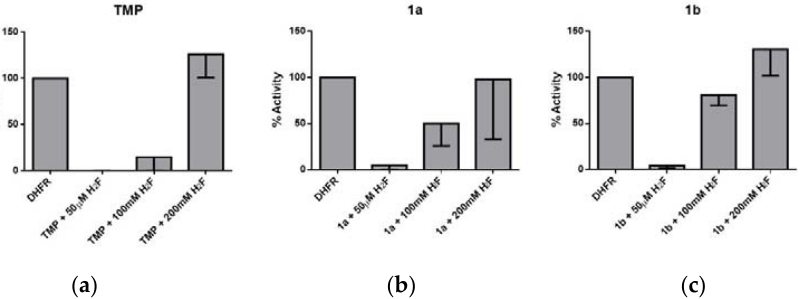
Figure 5. Percentage of activity of E. coli DHFR after a 30 ‐ min incubation. Each histogram represents the activity of DHFR in the presence of different concentrations of H 2 F and 5 μ M of the inhibitors ( a ) TMP, ( b ) 1a and ( c ) 1b . The data are expressed as a percentage with respect to the control.